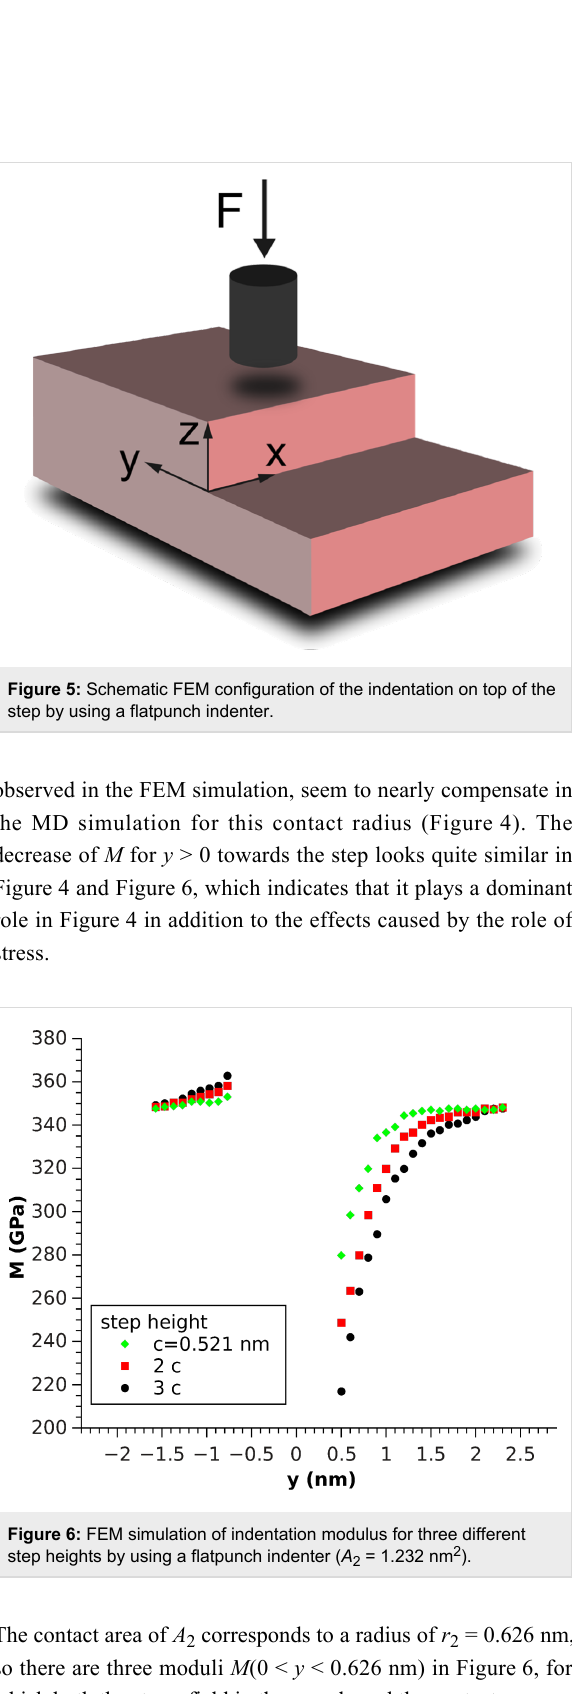
The contact area of A 2 corresponds to a radius of r 2 = 0.626 nm, so there are three moduli M (0 < y < 0.626 nm) in Figure 6, for which both the stress field in the sample and the contact area are shrinking as y approaches 0, due to the size of the contact area of the indenter. However, in this case, the change in the contact area manifests in a small bend and appears to play a minor